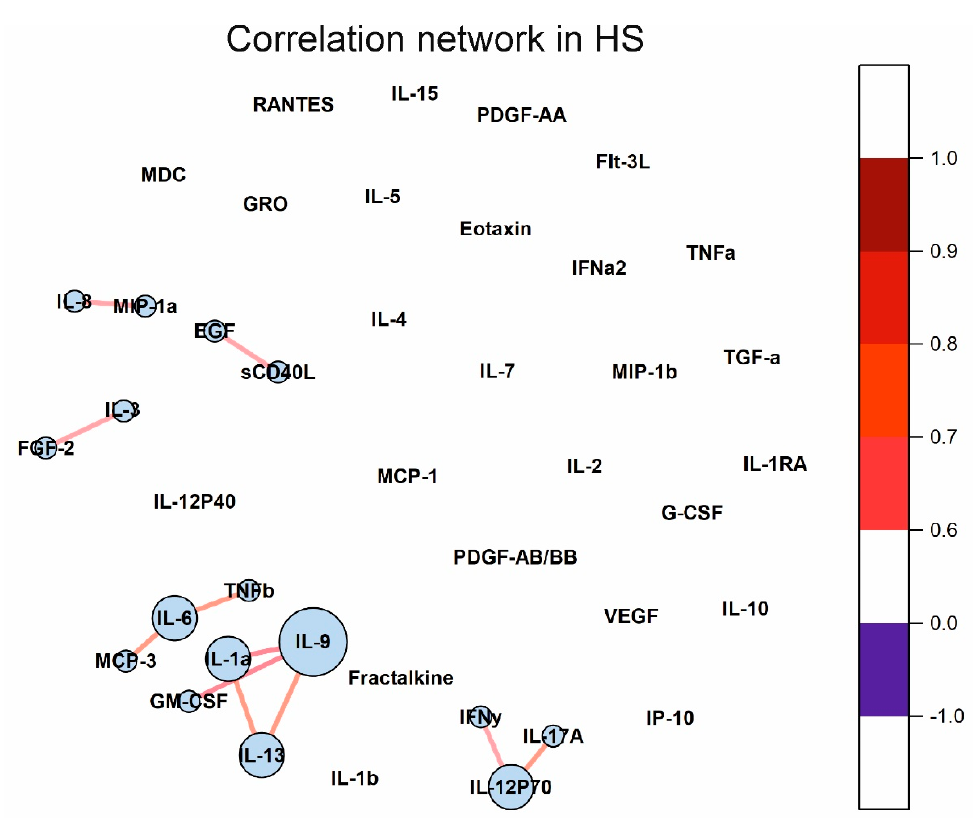
Figure 6. Cytokine correlation network in healthy donors. Correlations between concentrations of different cytokines are shown as colored lines. A scale showing the strength and direction of the correlation is shown in the right panel. Each cytokine is represented by a blue circle whose size is proportional to the number of statistically significant correlations.